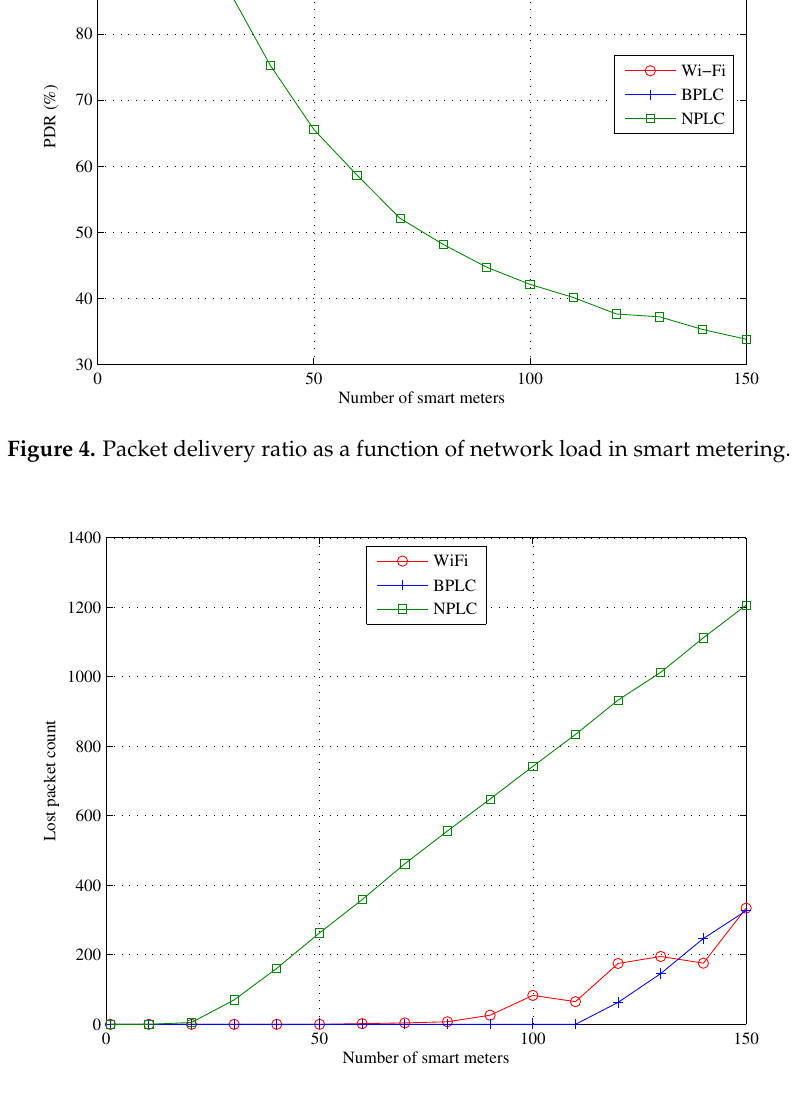
Figure 5. Comparing lost packets in wireless fidelity (Wi-Fi), broadband PLC (BPLC) and narrowband PLC (NPLC) in smart